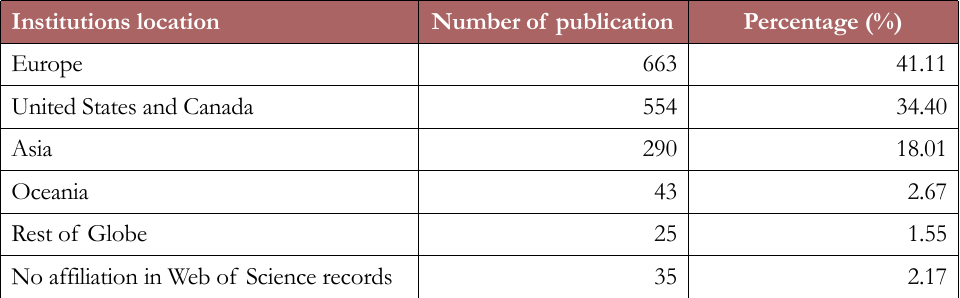
Table 5. Contribution of Institutions based on geographical